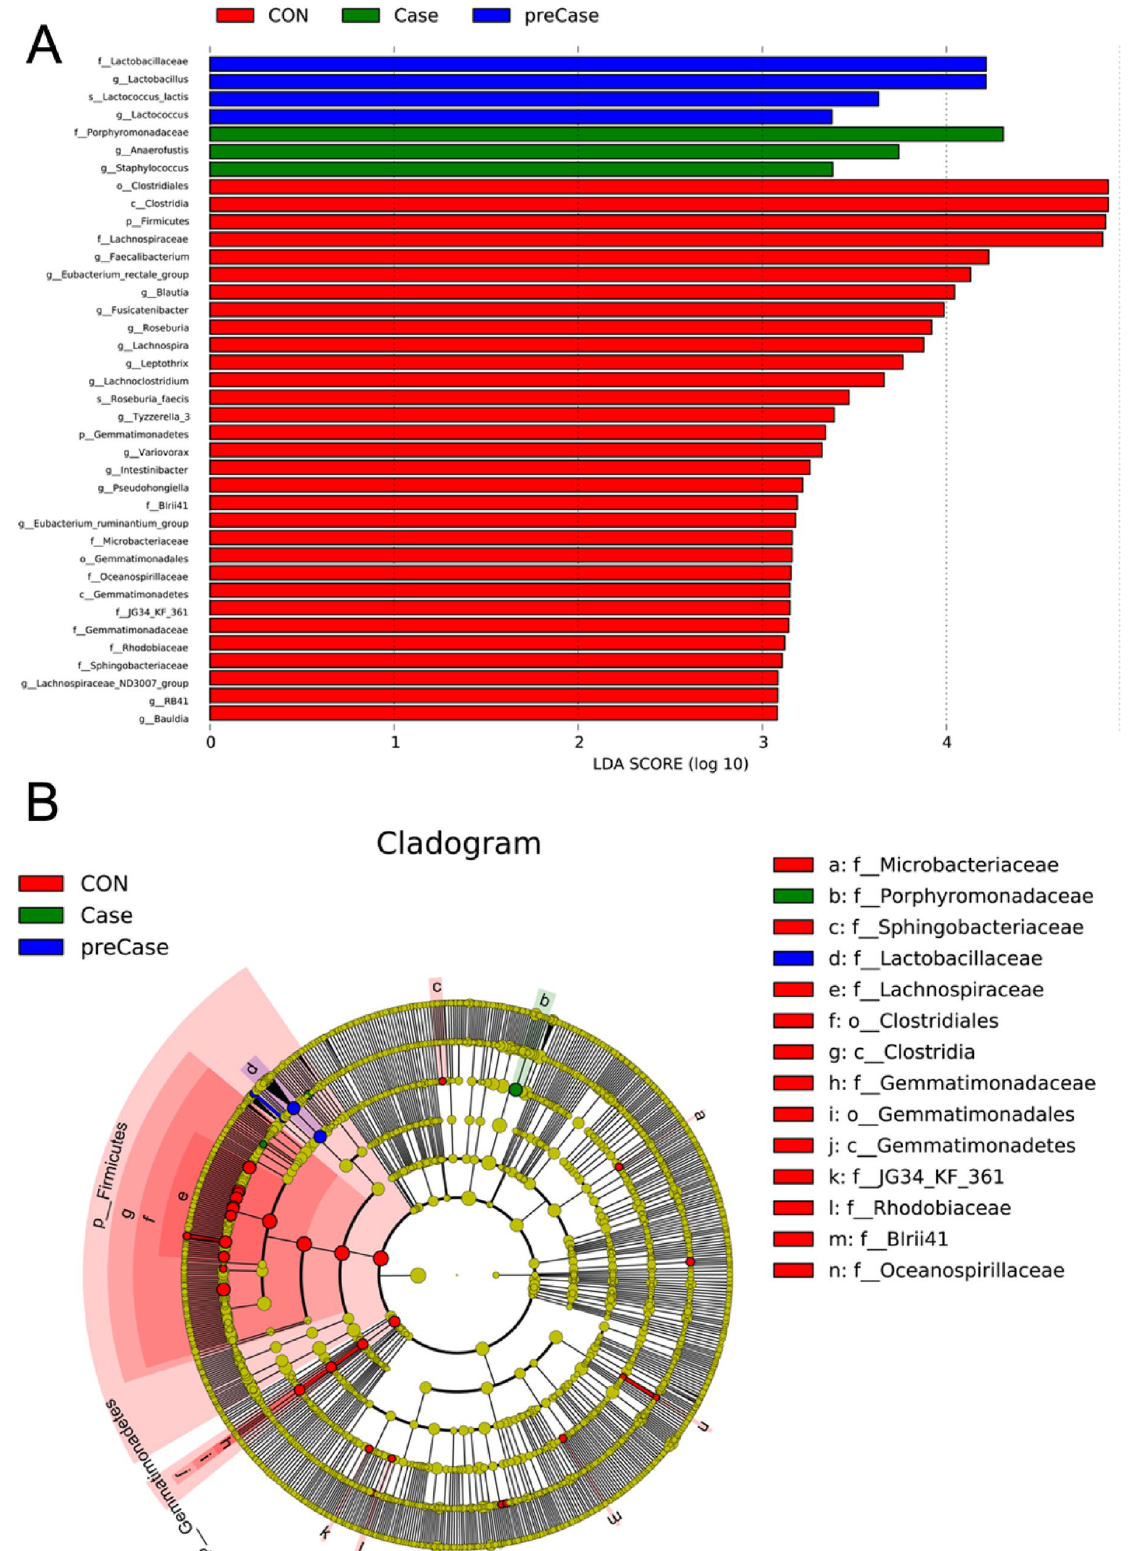
Figure 4. Taxonomic biomarkers of sarcopenia. ( A ) Linear discriminant analysis effect size (LEfSe) analysis comparing sarcopenic (Case) and possibly sarcopenic (preCase) patients with healthy controls (CON). ( B ) Cladogram displaying differentially abundant taxonomic clades with LDA score > 3.0 in Case, PreCase, and CON